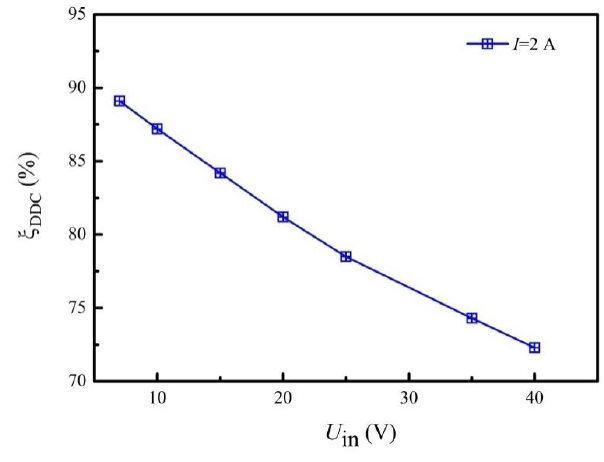
Figure 2. Transform efficiency of the DC-DC converters (DDC) ( U ld = 5 V).